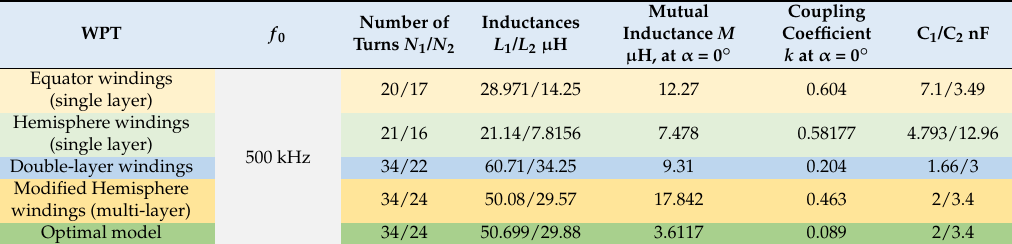
Figure 9. Some solutions of the optimization process: ( a ) equator windings; ( b ) hemisphere windings; ( c ) double-layer windings; ( d ) modified hemisphere windings; ( e ) optimal model. Table 2. Parameters of case studies.